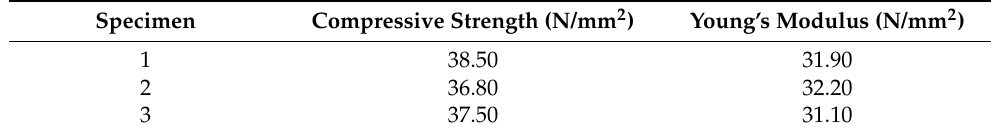
Figure 9. Design details for one-slab specimen (dimensions in mm) [6,7]. Table 1. Material test results of concrete